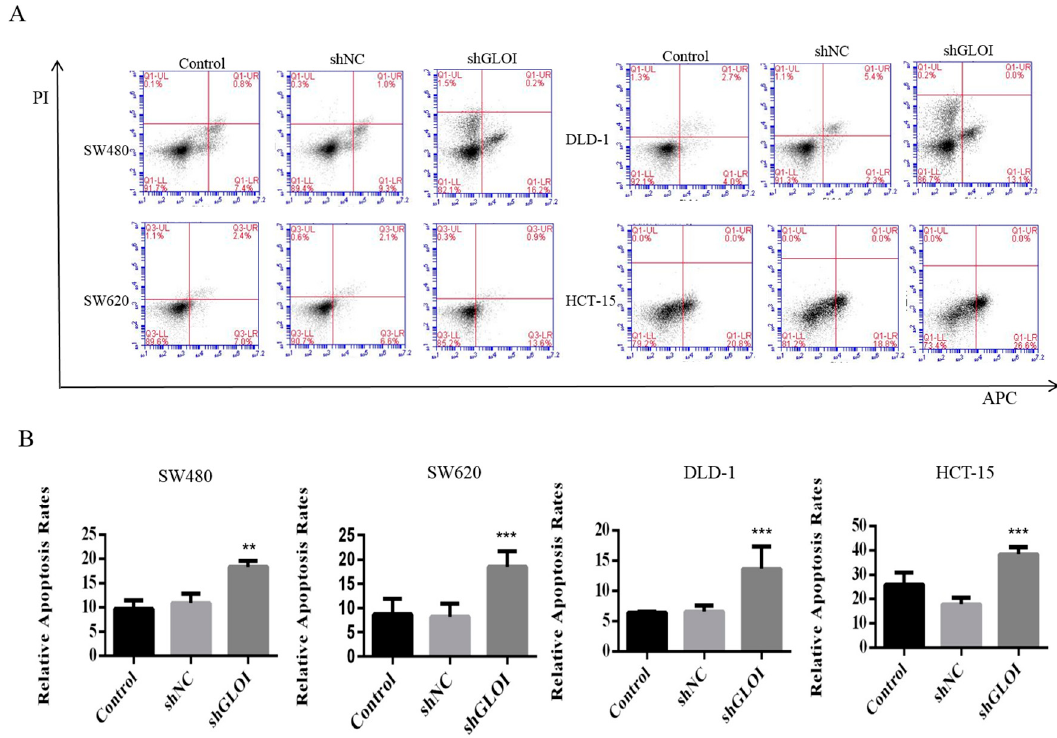
Figure 7. GLOI knockdown increases apoptosis in colorectal cancer (CRC) cells. ( A ) SW480, SW620, DLD-1, and HCT-15 CRC cells were transfected with shGLOI or shNC. The apoptotic cells were detected by annexin V–propidium iodide (PI) flow cytometry. ( B ) The apoptotic rate of each group of cells was quantified. ** p < 0.01, *** p < 0.001. All data are representative of three independent experiments ( n = 3).